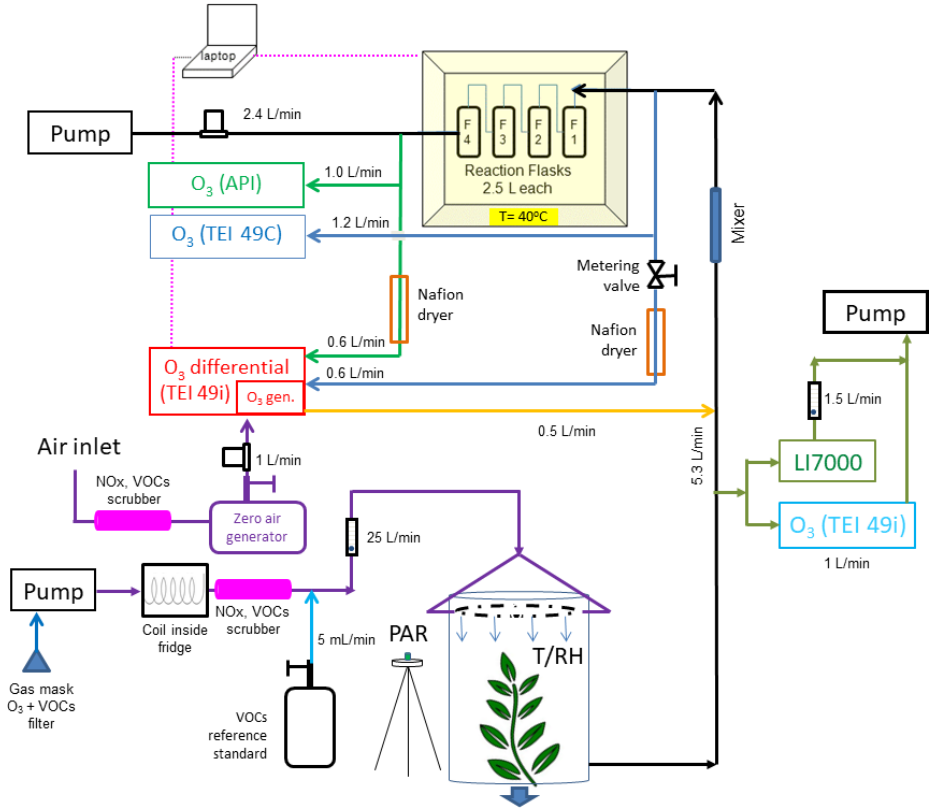
Figure 5. Total ozone reactivity monitor experiment as used in the field study (results shown in Fig. 6) with the differential ozone monitor, the sampling line pressure balancing valve, and the Nafion dryers. Note that this schematic does not include the purge flows for the Nafion dryers. These are described in Fig. 3b. Additional instrumentation for the monitoring of O 3 (TEI 419i), H 2 O, and CO 2 (LI7000) in the air drawn from enclosure is shown on the